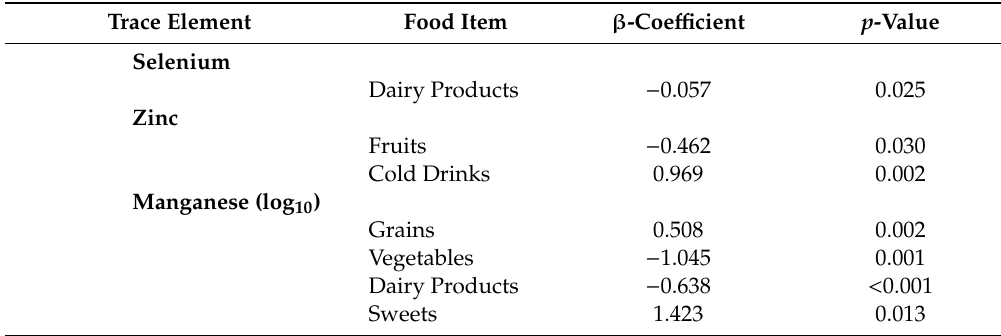
Table 5. Stepwise multiple linear regression analysing the association of the intake of di ff erent foods and beverages on the status of selenium, zinc, and manganese a,b